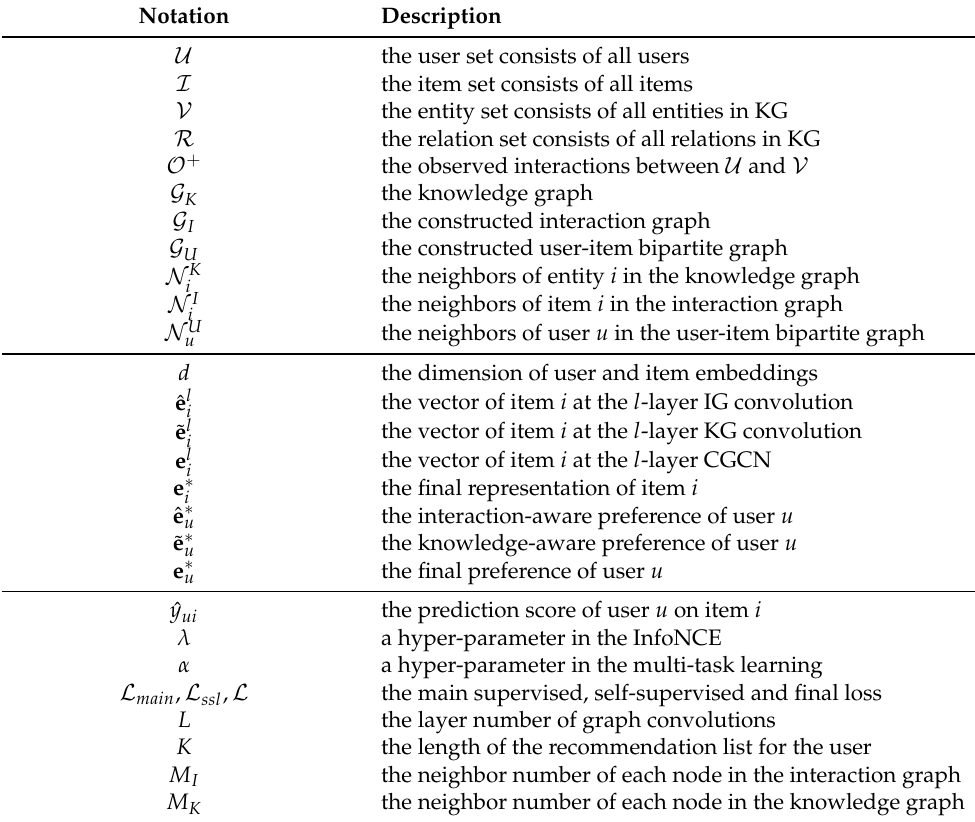
Table 1. Main notations used in this